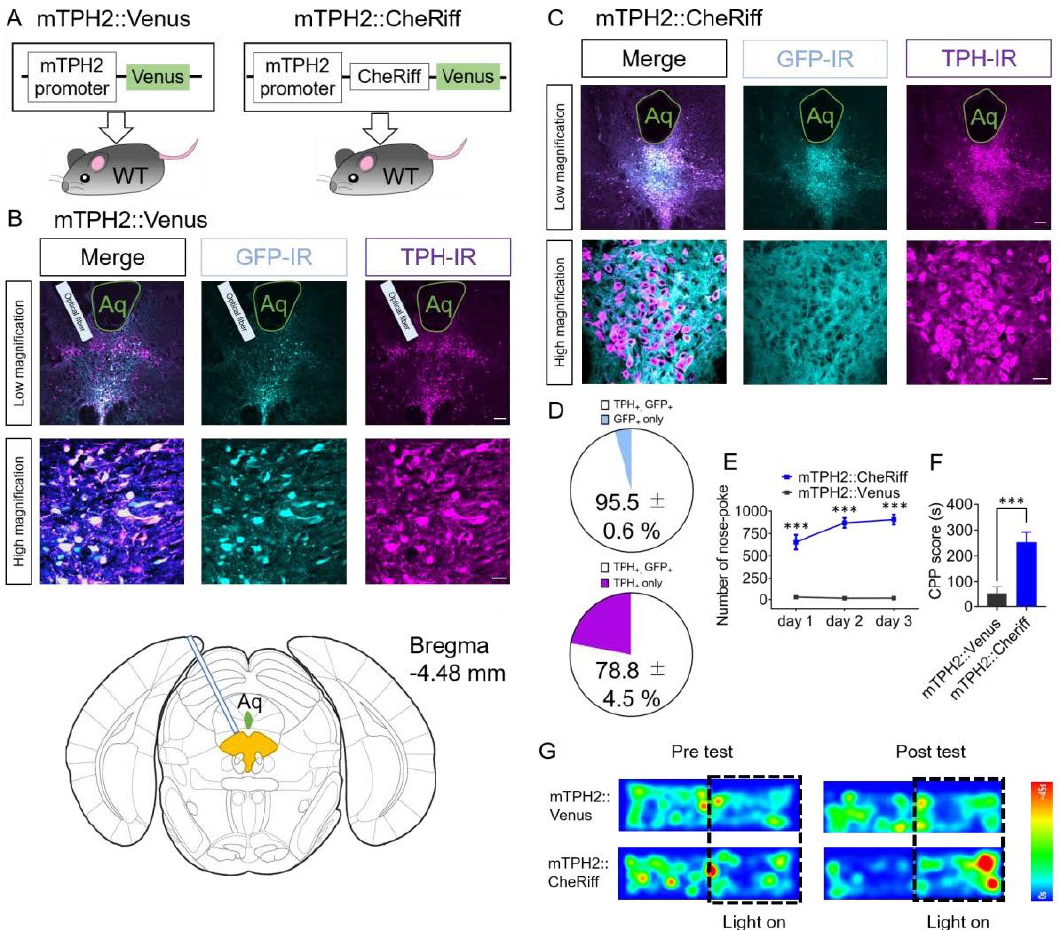
Figure 1. Stimulation of the dorsal raphe nucleus (DRN) serotonin (5-HT) neurons transduced by an adeno-associated virus (AAV) bearing the mouse tryptophan hydroxylase 2 (TPH2) promoter induces self-stimulation behavior and conditioned place preference. ( A ) Schematic of the experiment. ( B , C ) Four weeks after injection, coronal sections containing the dorsal raphe nucleus (DRN) were prepared and stained by anti-green fluorescent protein (GFP) and anti-tryptophan hydroxylase (TPH) antibodies. Stained sections were imaged using confocal microscopy. Scale bars = 100 μm (low magnification), 20 μm (high magnification). Aq, Aqueduct. (B, bottom panel) Drawings of the coronal section including injection site from the Atlas. DRN is colored in yellow. ( D ) The number of TPH- and GFP-immunoreactive cells in mTPH2::Venus injected animals were counted. (Top) Data represent mean ± SEM of the percentage of double-positive cells in GFP-positive cells. (Bottom) Data represent mean ± SEM of the percentage of double-positive cells in TPH-positive cells. n = 4 mice. ( E ) After injection of mTPH2::Venus or mTPH2::CheRiff, the number of nose-poke responses in the operant chamber was measured. Blue light (20 Hz, 10 ms duration, 20 pulses, 5 mW) was delivered when mice performed nose-poke responses. Data represent mean ± SEM. n = 7 (Venus), 15 (CheRiff) mice. *** p < 0.001 vs. Venus (Day 1; mTPH2::Venus, 28.9 ± 2.3, mTPH2::CheRiff, 652.7 ± 82.5, Day 2; mTPH2::Venus, 15.9 ± 4.8, mTPH2::CheRiff, 868.4 ± 55.1, Day 3; mTPH2::Venus, 17.1 ± 4.9, mTPH2::CheRiff, 906.5 ± 55.9; two-way repeated-measures ANOVA; Interaction, F(2, 40) = 6.59, p = 0.0034, Time, F(1.218, 24.35) = 5.37, p = 0.024, Opto, F(1, 20) = 83.84, p < 0.001, Subject, F(20, 40) = 7.08, p < 0.001; Bonferroni posttests; Days 1 – 3, *** p < 0.001). ( F ) In the conditioned place preference (CPP) test, spent time in the chamber associated with blue light illumination to the DRN was examined. Data represent mean ± SEM. n = 9 mice (Venus, CheRiff). *** p < 0.001 vs. Venus. (mTPH2::Venus, 51.39 ± 26.53 s, mTPH2::CheRiff, 253.2 ± 38.2 s; unpaired t -test; p = 0.0005). ( G ) Representative heat map of mouse movement during the pretest at Day 1 and posttest at Day 4. WT, wild type; IR, immunoreactivity.